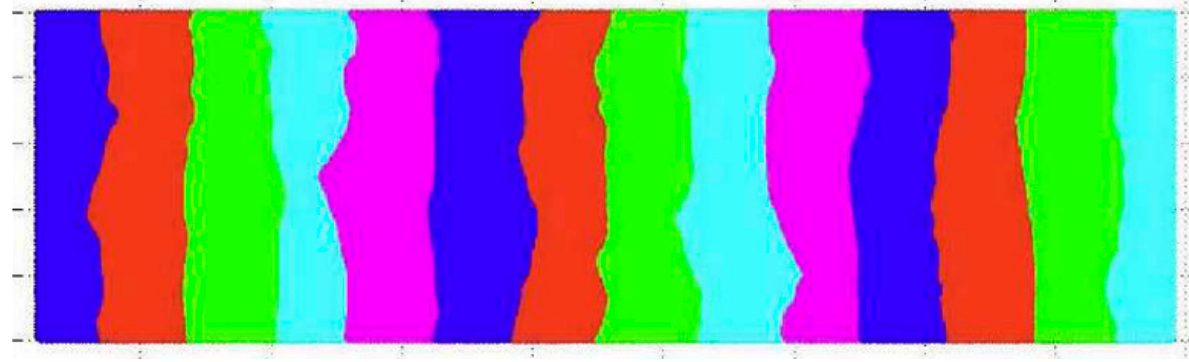
Figure 1. Area coverage of a portion of the 14 strips. Imprecision in the GPS positioning, the INS orientation, component misalignments, errors in the angle encoder and other sources of error, cause the same ground spot in two adjacent overlap strips to have two different coordinates. This leads to systematic errors in position and attitude and may produce a tilt in the resulting scanned surface. model presented in [33] for strip adjustment. In this model, errors are modeled by three offsets, three rotations, and three time-dependent rotations. Tie points in adjacent strips were identified and least squares matching was applied to laser scanner data points to achieve higher relative accuracy between adjacent